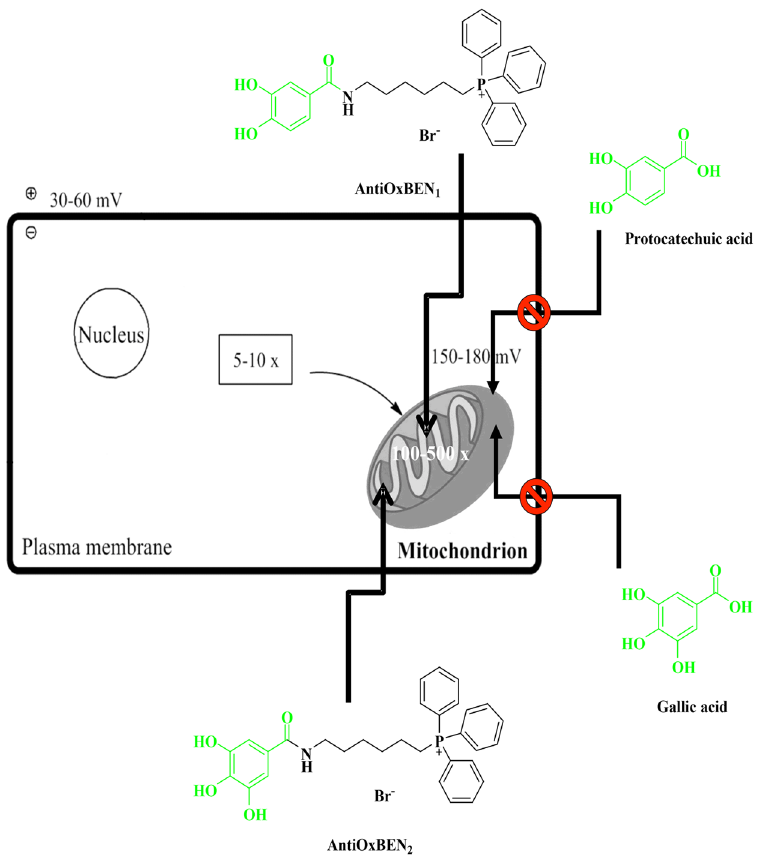
Figure 1. Design of mitochondriotropic antioxidants (AntiOxBEN 1 and AntiOxBEN 2 ) based on dietary scaffolds (protocatechuic and gallic